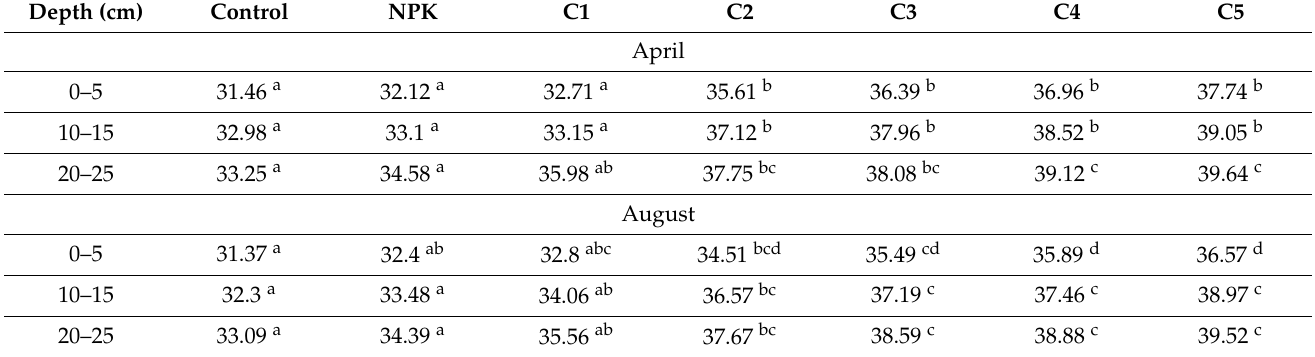
Table 3. Chernozem soil—Moisture v/v %. Control (without fertilization), NPK K 2 O in